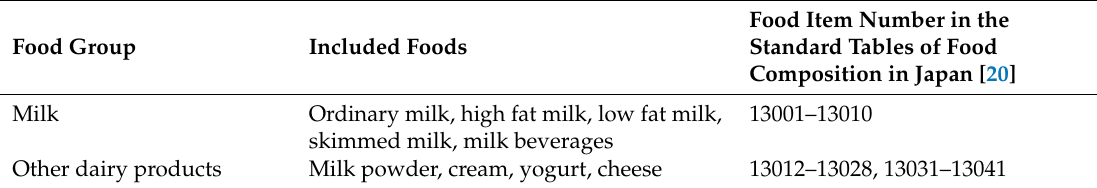
Table 1. Definition of milk and dairy products in the